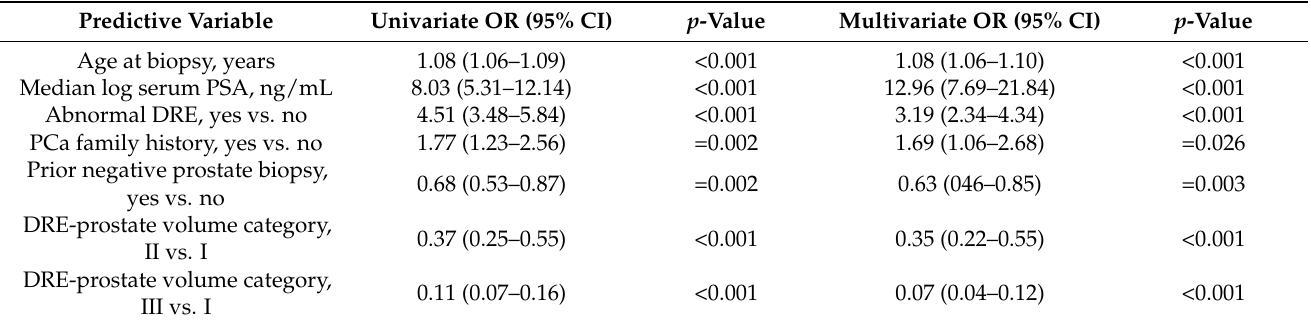
Table 2. Odds ratios and 95% confidence intervals for csPCa of independent predictive values in univariate and multivariate